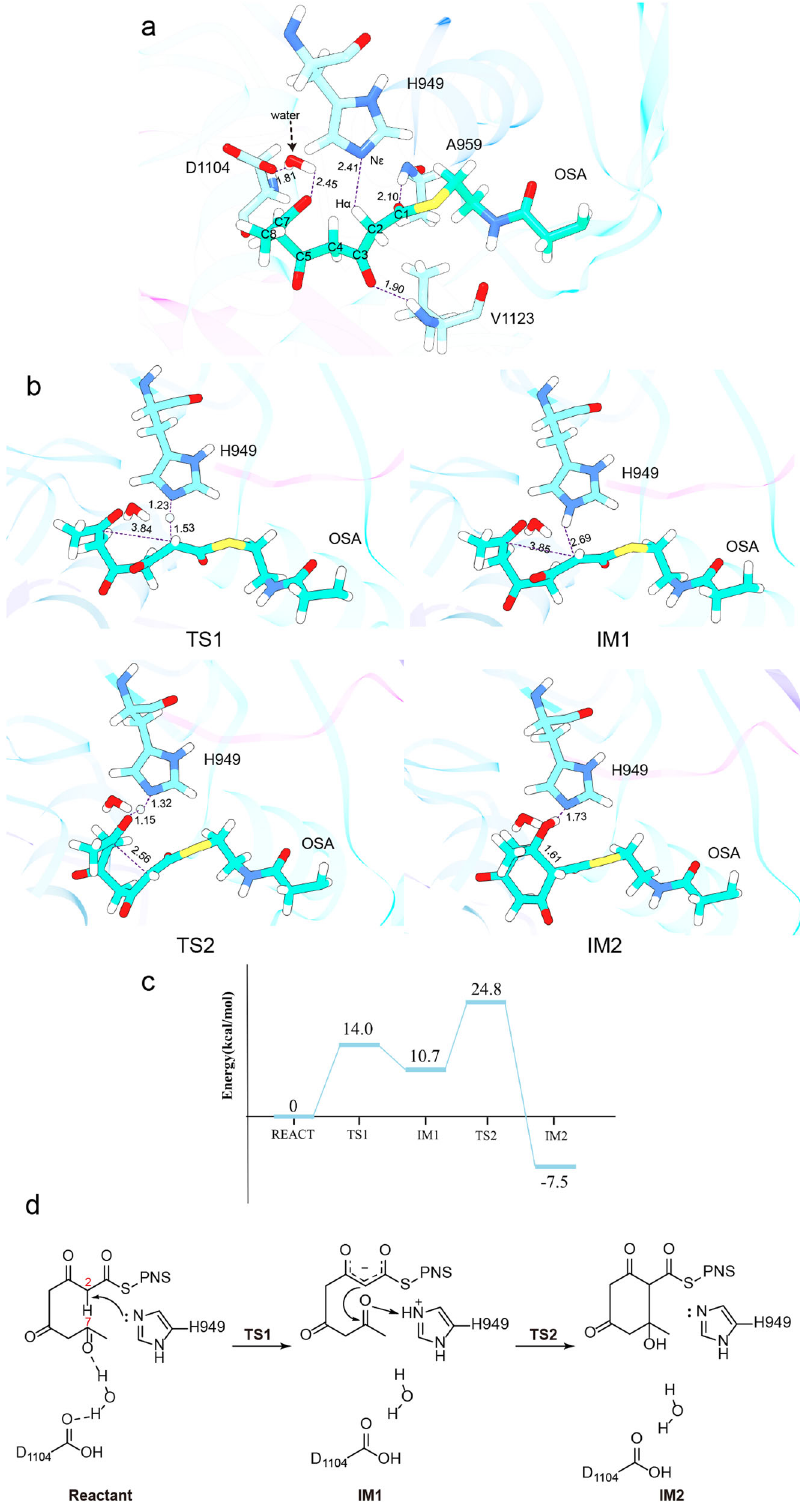
Fig. 5 QM/MM calculation of AviM PT complexed with the substrate. a Optimized structure of reactant. b Structures of TS1, IM1, TS2 and IM2. In the fi rst stage, the C2 is deprotonated by the N ε of the catalytic H949. Next, the nucleophilic C2 launches an attack on the C7 leading to the C2 – C7 cyclization. c The energy pro fi les for the deprotonation of C2 and the ring formation at the M06-2x/6-31 G(d): AMBER level. The distances are given in Å. d Schematic representation of the proposed mechanism for AviM PT. In reactant, the N ε of catalytic H949 abstracts proton from C2, catalytic D1104 and water molecule stabilize the substrate by hydrogen bonds. In IM1, enolate intermediate forms after deprotonation of C2. In IM2, C2 – C7 aldol addiction occurs.